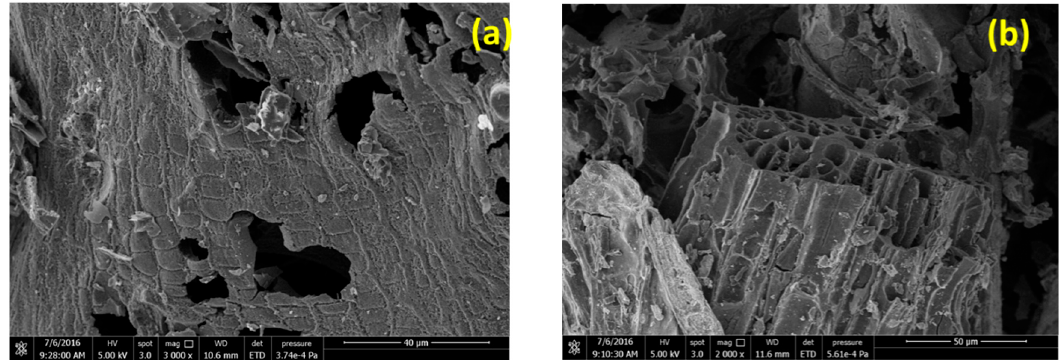
Figure 3. SEM image for the biochar treated with H 2 SO 4 0.1 M ( a ) and NaOH 0.1M ( b ).